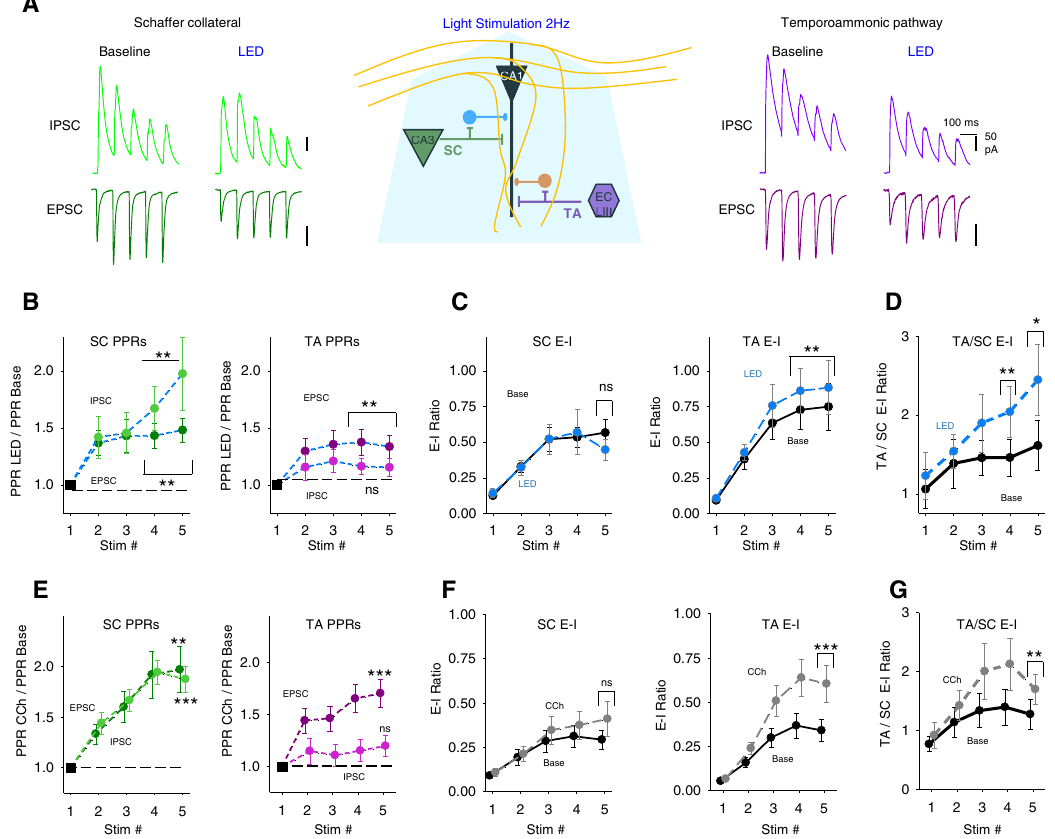
Fig. 2 Acetylcholine release enhances excitatory – inhibitory balance for temporoammonic synaptic inputs relative to Schaffer collateral inputs. A Middle, schematic representation of the experimental approach incorporating simultaneous recording of excitatory ( V h = − 60 mV) and feedforward inhibitory ( V h = 0 mV) synaptic inputs from Schaffer collateral (SC) and temporoammonic (TA) input pathways to CA1 pyramidal neuron (bottom). Example traces for EPSCs and IPSCs in response to trains of 5 stimuli at 10 Hz to SC (green, left) and TA (purple, right) pathways before and after light stimulation (LED) of cholinergic fi bres at 2 Hz for 5 min. B Change in paired-pulse ratio (PPR) after light stimulation of cholinergic fi bres for excitatory and inhibitory responses to SC (left) and TA (right) pathway stimulation (5th stimuli PPR change for SC EPSC, n = 20 from 13 mice, p = 0.010; SC IPSC, p = 0.007; TA EPSC, p = 0.003; TA IPSC, p = 0.073). PPR is measured compared to the fi rst response for each response in the train. C Comparison of synaptic Excitatory – Inhibitory (E – I) ratio before and after light stimulation measured by charge transfer at V h = − 60 mV and 0 mV for SC (left) and TA (right) input pathways (5th stimuli on SC E – I ratio, p = 0.059; TA E – I ratio, p = 0.007). D Comparison of synaptic E – I ratio between TA and SC input pathways before and after light stimulation. Acetylcholine release enhanced the overall relative synaptic charge transfer from the TA pathway (5th stimuli on TA-SC E – I ratio, p = 0.016). E – G similar quanti fi cation to B – D for experiments using bath applied exogenous carbachol (CCh, 10 µ M) ( E 5th stimuli PPR change for SC EPSC, n = 20 from 11 mice, p = 0.002; SC IPSC, p = 0.00002; TA EPSC, p = 0.0003; TA IPSC, p = 0.220. F 5th stimuli on SC E – I ratio, p = 0.285; TA E – I ratio, p = 0.0002. G 5th stimuli on TA-SC E – I ratio, p = 0.002). Data are mean ± SEM; comparisons are two-tailed paired t -test *** p < 0.001, ** p < 0.01, * p < 0.05. Source data are provided as a Source Data fi le. faster decay kinetics than TA IPSCs (Fig. 3A – C; SC IPSC decay tau, 43.0 ± 2.7 ms, n = 45 from 24 mice vs TA IPSC decay tau, 60.1 ± 3.4 ms, n = 92 from 36 mice, p < 0.005). This con fi rms the sti- mulation of distinct interneuron populations and signi fi es either dis- tinct GABAergic subunits at those synapses or that the more distal synaptic location of inhibitory inputs from TA feedforward inter- neurons and therefore increased dendritic fi ltering means that these IPSCs have slower kinetics 34 . GABAergic synapses from PV + and NPY + , but not CCK + , interneurons onto CA1 pyramidal cells are depressed by µ-opioid receptors 45 – 47 . SC IPSCs were more sensitive to µ-opioid receptor agonist DAMGO (1 µM) than TA IPSCs (Fig. 3D, E; IPSC 1st response peak after DAMGO, 51 ± 4% and 69 ± 5%, for SC and TA, respectively, n = 11 from 4 mice, p < 0.05) indicating that in our experiments PV + interneurons form a major component of feedforward inhibition in the SC pathway whereas CCK + interneurons form the major component of feedforward inhibition in the TA pathway. There are also minor components from other interneuron